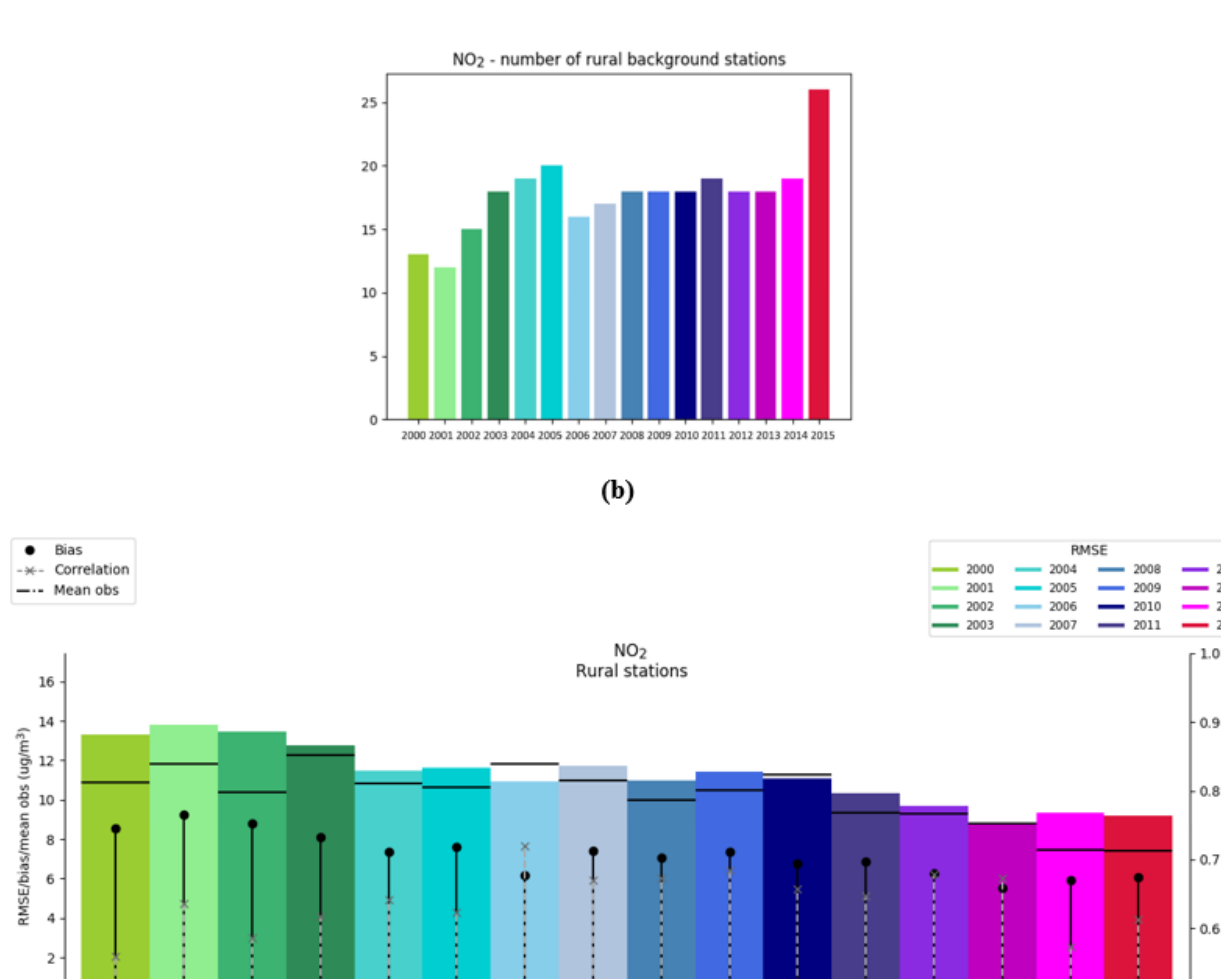
Figure 7. NO 2 : statistical indicators calculated using cross-validation technique on daily mean NO 2 values measured and estimated over rural background stations for the years 2000 to 2015. (a) Number of rural stations for each year. (b) Bias (black circles), RMSE (colored rectangles), correlation (grey crosses and the associated dashed lines) and mean observation (horizontal